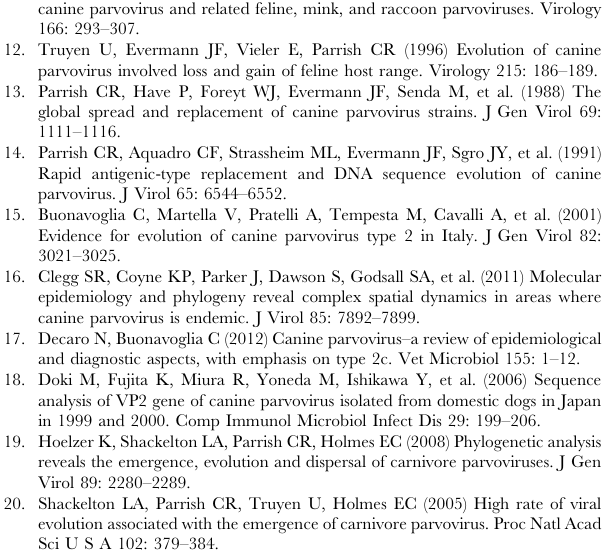
two PCR amplicons that together span the entire